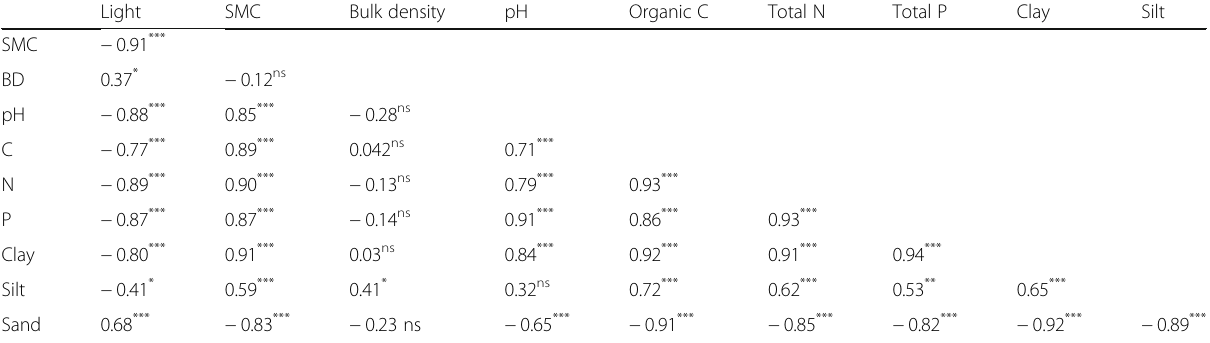
Table 3 Pearson correlation coefficients between soil properties across experimental sites and light conditions Light